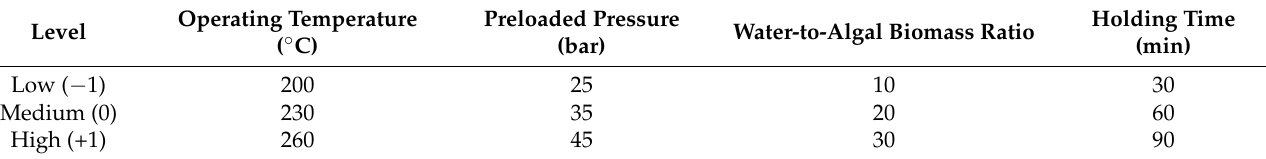
Table 2. Studied parameters with respective levels.